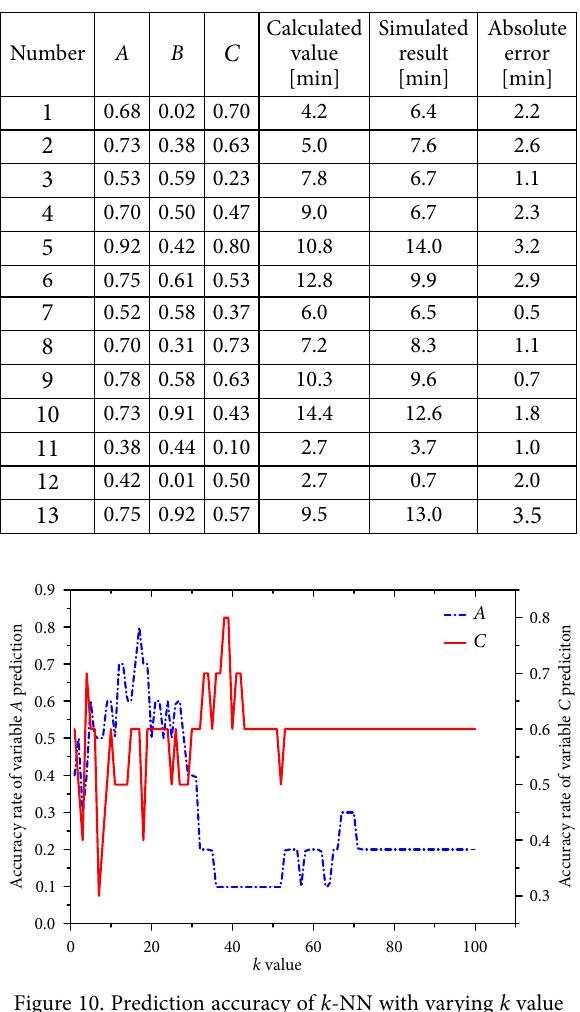
Figure 8. Surface of fuzzy inference: a – inference of ABD ; b – inference of BCD ; c – inference of ACD Table 7. Verification of the fuzzy expert system result